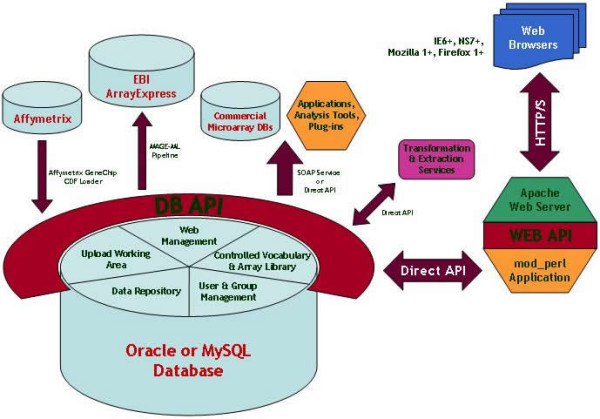
The MIMAS system architecture. A schematic overview of the database and its services as well as web front-end components is shown.